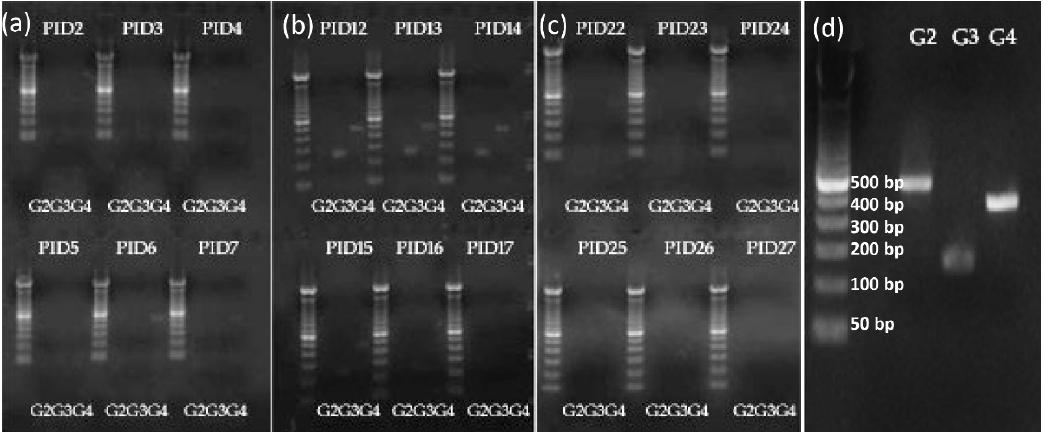
Figure 2. Representative images of fecal virus shedding were detected by VP7-specific RT-PCR. The shedding of reassortant virus strains in TLV from the Gn pigs in the TLV+LGG group was monitored after the oral administration of each vaccine dose. ( a ) Fecal swabs collected after dose 1 inoculation; ( b ) fecal swabs collected after dose 2 inoculation; ( c ) fecal swabs collected after dose 3 inoc- ulation; ( d ) RT-PCR amplification of G2, G3, and G4 DNA fragments from mixed positive control by using rotavirus VP7-specific G2, G3, and G4 typing primers detailed in Table 1.